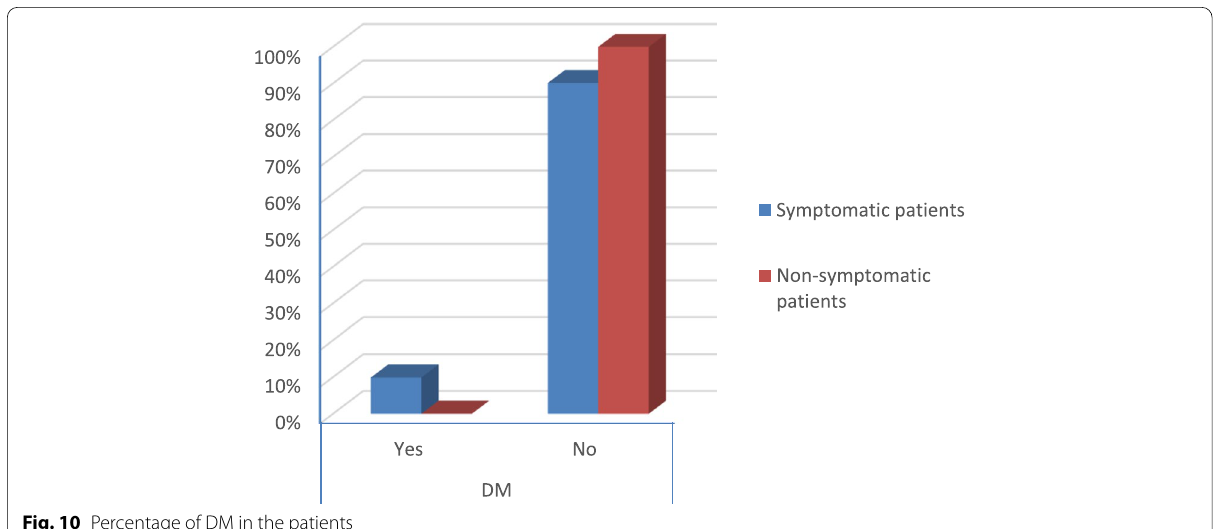
Fig. 10 Percentage of DM in the patients